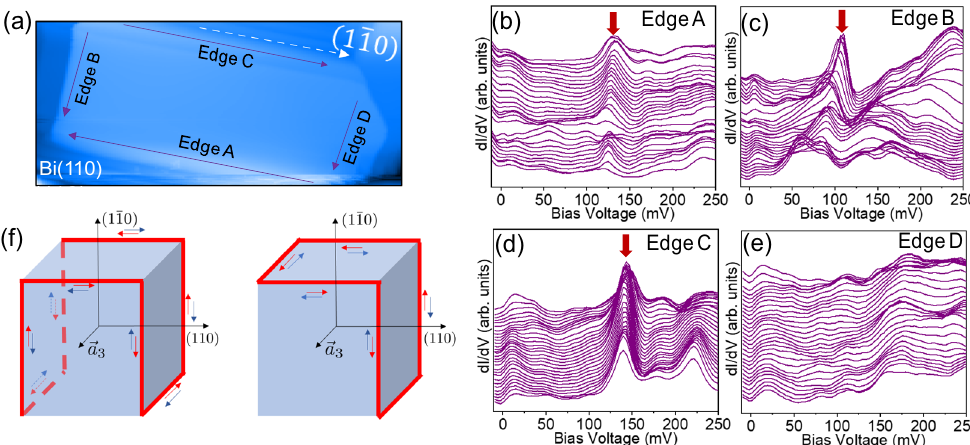
Fig. 3 Metallic modes at the edges of the rectangular island of Bi(110). a Topographic image of a Bi(110) rectangular island of 168 nm × 80 nm area. The four edges of the island are marked as Edge A, Edge B, Edge C, and Edge D, respectively. The dotted white arrow shows the (1 (cid:1) 10) direction. b − e STM spectra (at ac modulation 3.5 mV and current 60 pA) along the four edges (as shown by purple arrows in ( a )). A constant slope was subtracted from each spectrum for clarity. The raw data without slope subtraction is shown in Supplementary Fig. 3b, c, d, and e. The red block arrows indicate the sharp peaks corresponding to the edge modes that are only seen on three of the four edges. f Two possible con fi gurations of helical hinge modes for Bi in the HOTI ! phase, where three edges of a rectangular island on a (110) facet hold helical modes. The a 3 indicates a lattice vector of the Bi crystal as shown in Fig.